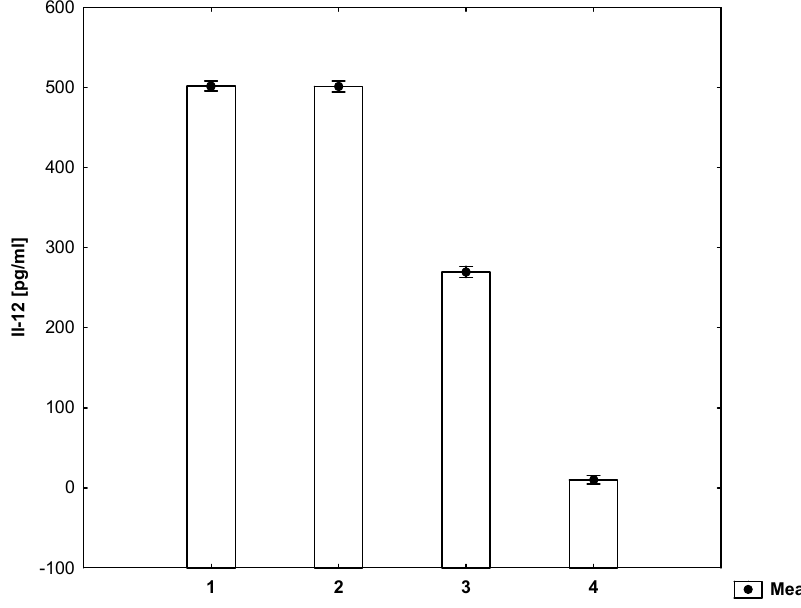
Figure 5. Concentrations of Il-12 in the cell culture supernatant (ANOVA). 1—cell suspension + mitogen + homocysteine, 2—cell suspension + mitogen, 3—cell suspension, 4—medium.